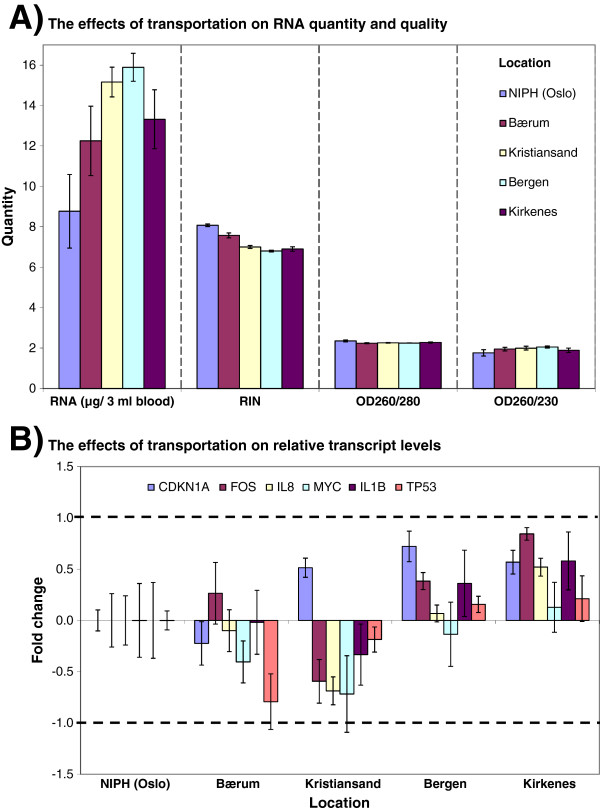
The effects of transportation on RNA, quantity, quality and transcript stability. Adult blood from one healthy donor was collected in Tempus™ tubes (n = 20). Samples were divided randomly into five groups (n = 4 tubes per group): four groups were sent by standard mail to four different hospitals in Norway, and the fifth group was kept at NIPH (Oslo/lab). Temperature was monitored during transportation. A) The effects of transportation on RNA quality and yield; B) The effects of transportation on RNA transcript levels of six genes. Samples kept at NIPH were used as reference samples; hence all other samples were compared against the reference samples. Each bar represents the average log2-transformed fold change values and the error bar indicates ± SE. The dashed lines indicate ± 2 – fold change.